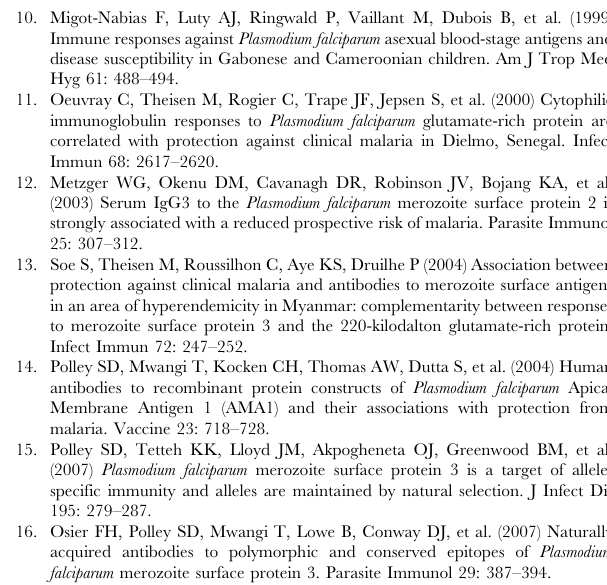
Table S1 Summary of PfMSP1-19 specific inhibition levels reported in different